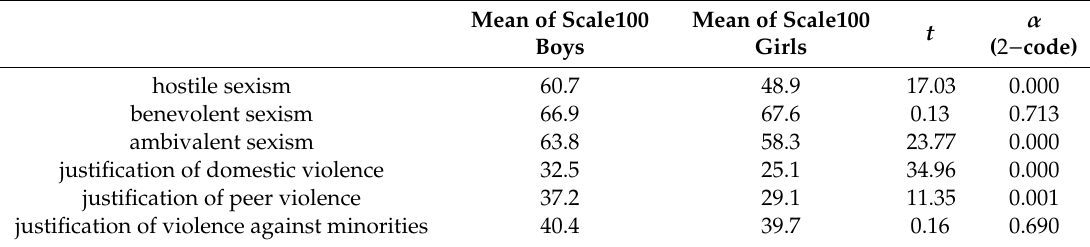
Table 1. t -test for the additive scales.